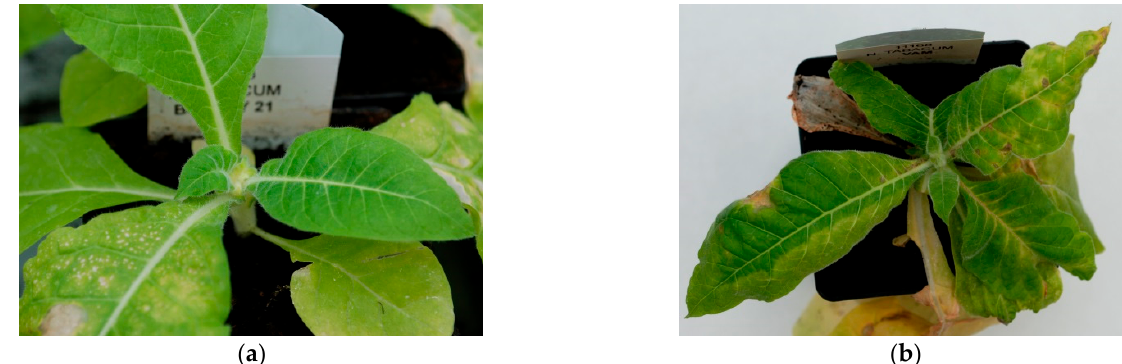
Figure 6. Stunted growth, chlorotic and necrotic spots of ( a ) tobacco cv. Burley 21 and ( b )tobacco cv. VAM four weeks after TSWV inoculation.